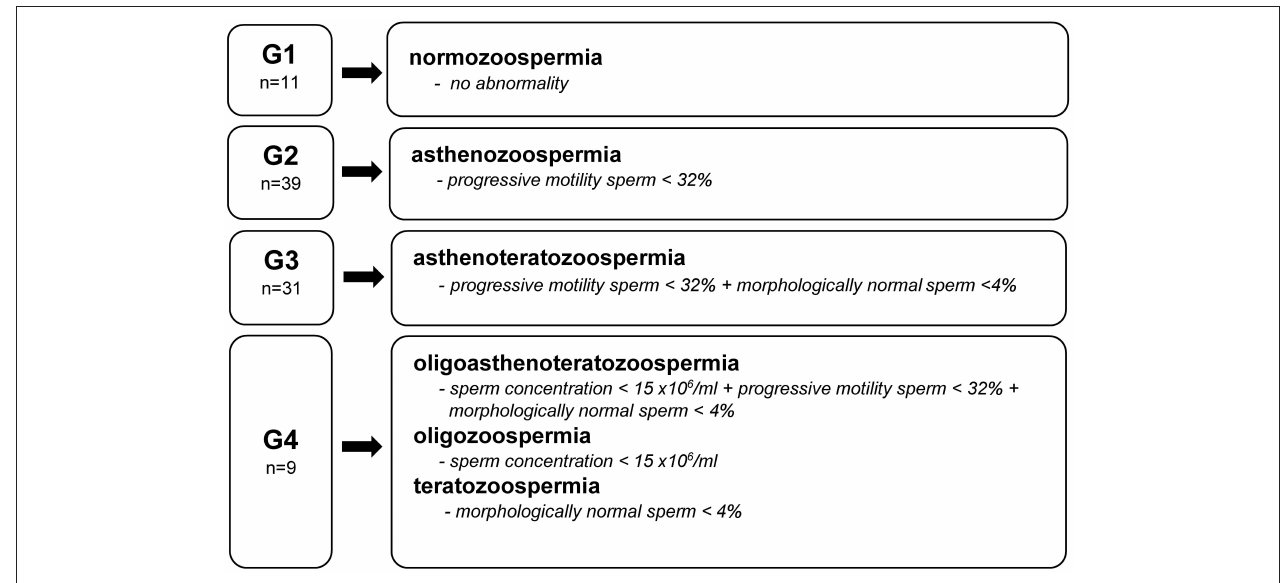
FIGURE 1 | Groups (G) of men by semen diagnosis and WHO reference value